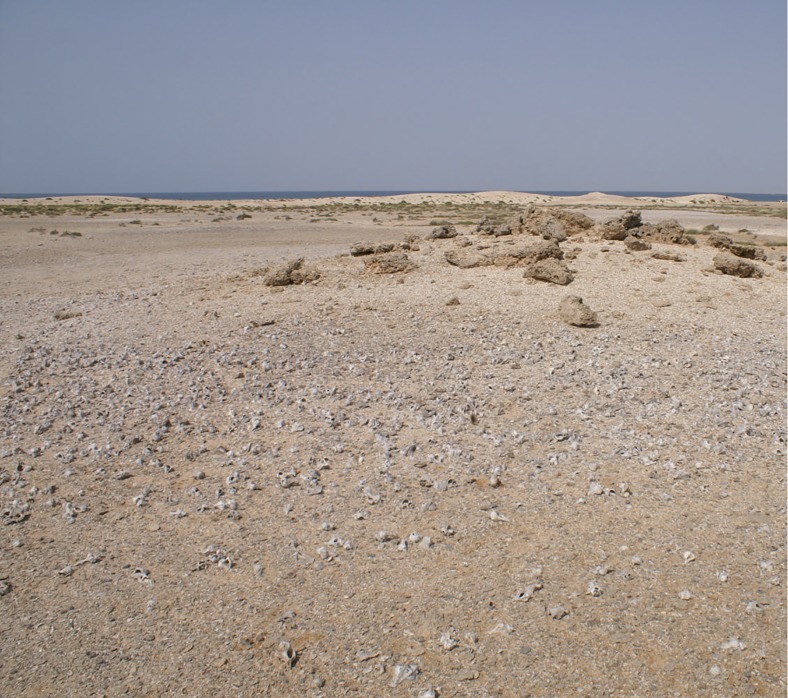
Post-shore shell scatter in the Janaba East cluster associated with Transect 3.The site appears to be a low mound with a deflated shell scatter on the surface and coral blocks representing the remains of structures but has not been excavated or dated. Photograph taken facing West, shell mounds along palaeoshorelines are clearly visible in the distance. To the right is the shell scatter of JE5641, identifiable by the patch of red material, which is the spoil heap from the trench excavated into this deposit. Photo by Geoff Bailey, February 2013.